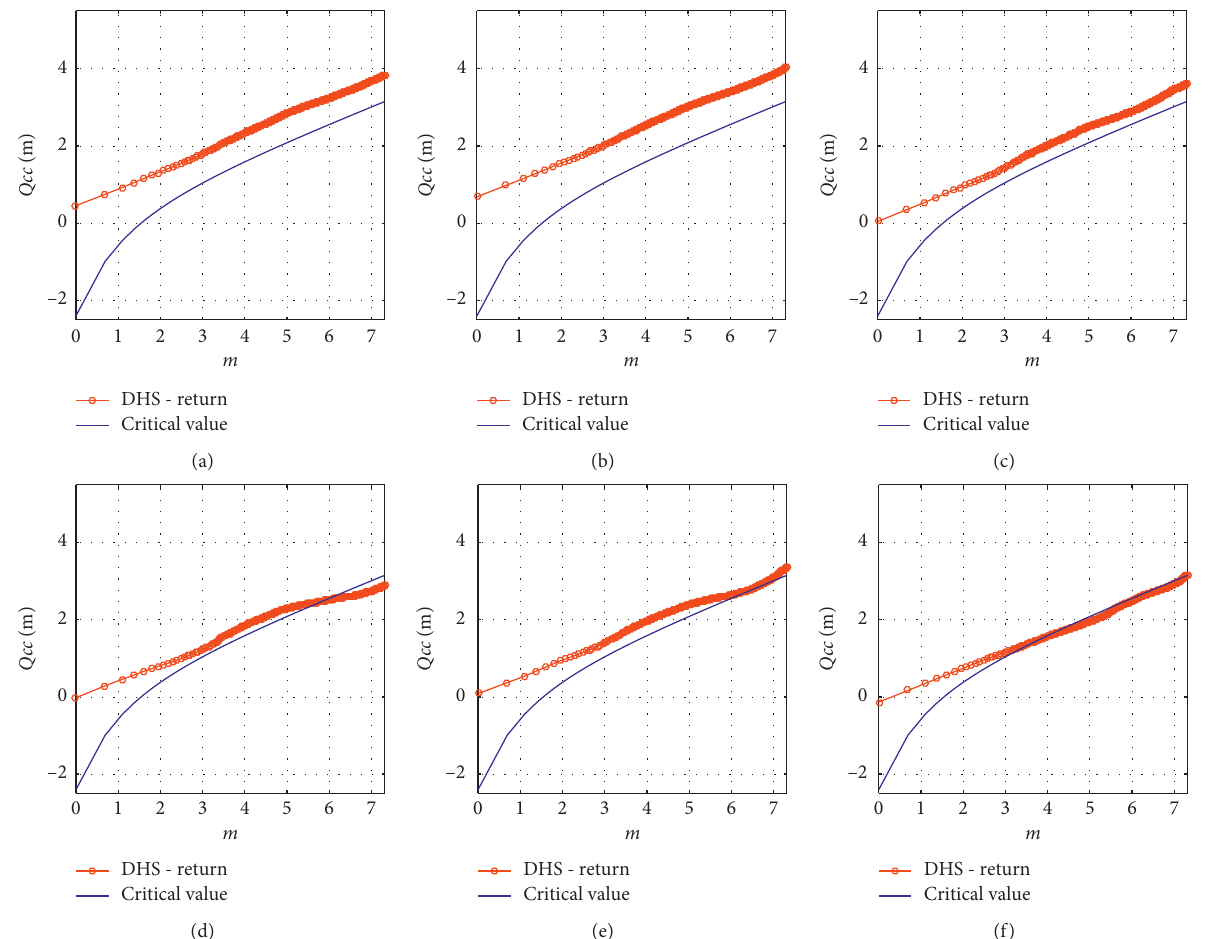
Figure 2: The cross-correlation statistics between online sentiment (DHS) and stock market return in developed countries: (a) US: SP500, (b) US: Nasdaq, (c) Japan: Nikkei, (d) Korea: KOSPI, (e) Germany: DAX, and (f) UK: